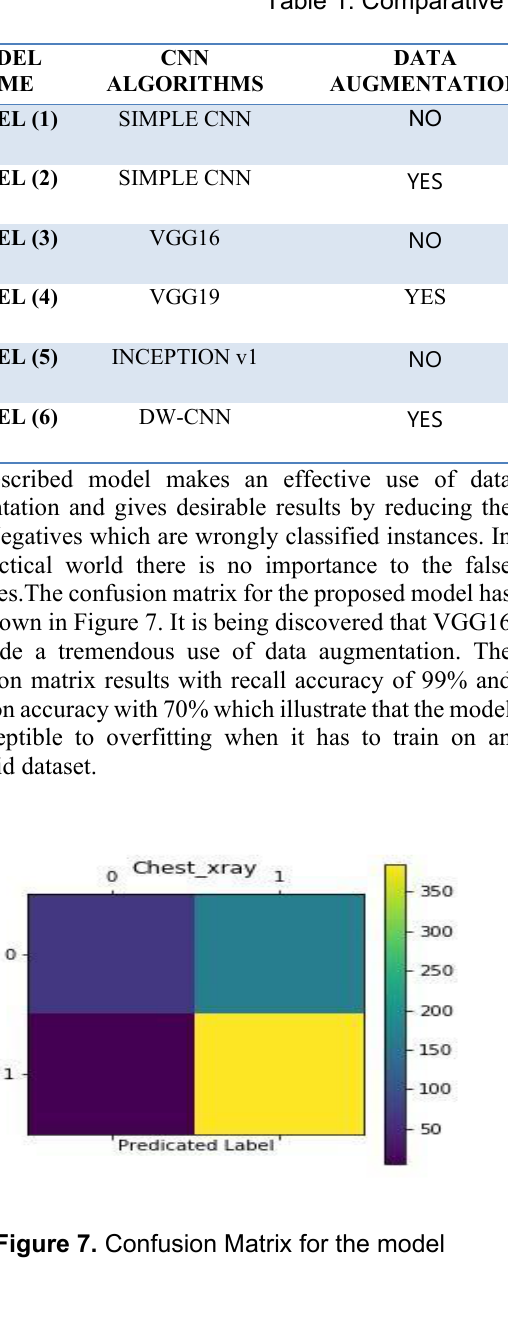
Table 1. Comparative Analysis of different CNN